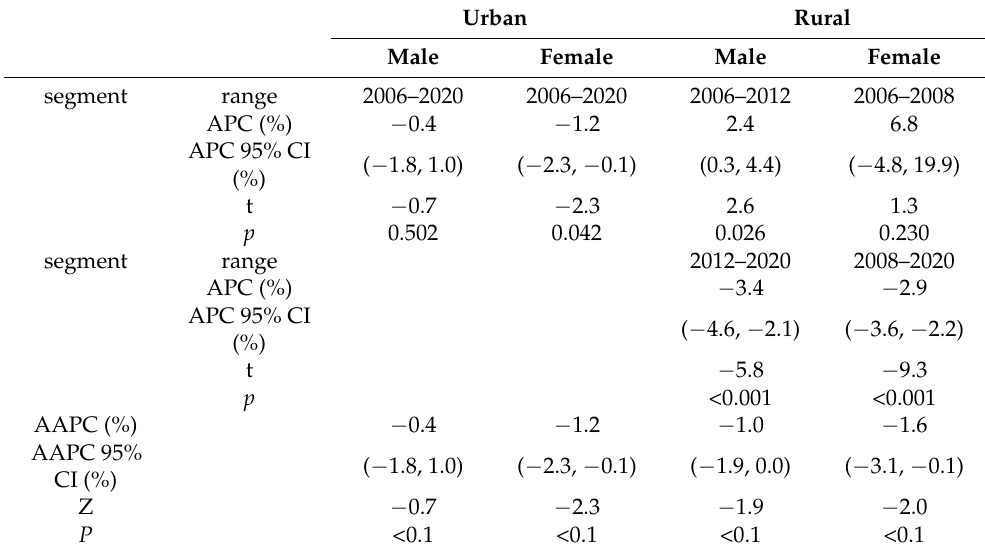
Table 2. Changes in standardized mortality rates of injury and poisoning by gender and